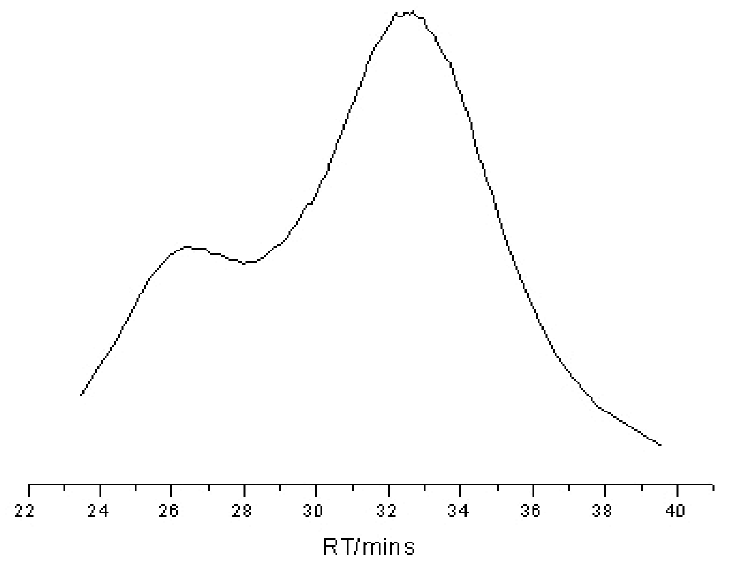
Fig. 2 GPC graph of polyethylene (Entry